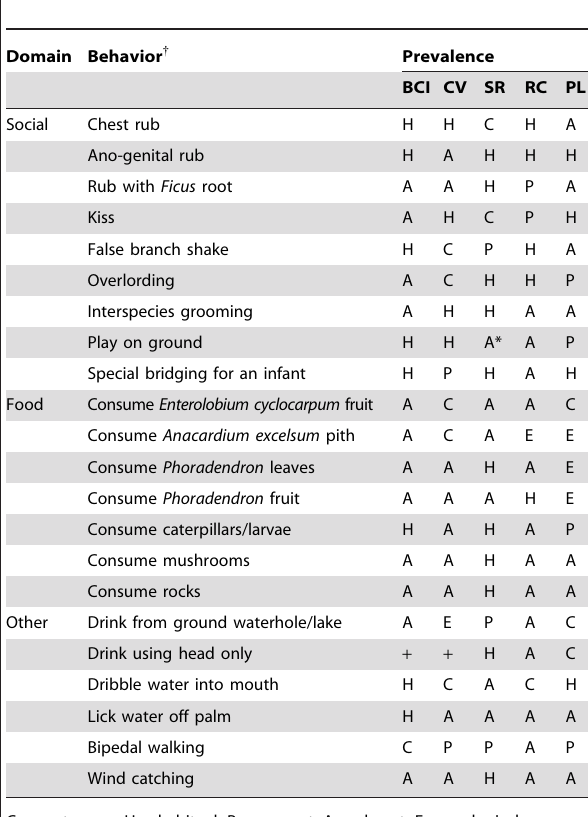
Table 1. Prevalence of the 22 behaviors which met criteria for traditions across the five sites.